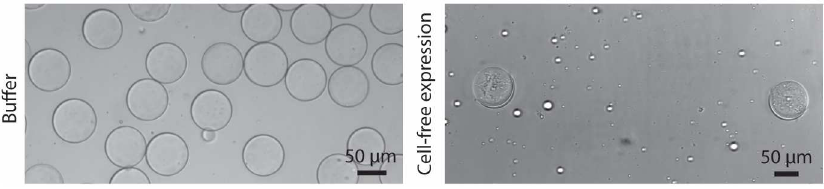
Fig 2. Aggregate was observed when CFE is encapsulated in the vesicle. (Top) Buffer solution (20 mM HEPES pH 7.5, 400 mM sucrose, 2% PVA, 8% PEG) was encapsulated as the inner phase using capillary droplet microfluidics with DOPC/cholesteroldissolvedin chloroform/hexaneas the middlephase (see materials and methods) (Bottom) HeLa CFE (18 μ l HeLa lysate, 4.5 μ l Mix 1 buffer, 5.4 μ l GADD34, 4.5 μ l T7 RNA polymerase, 3.6 μ l Mix 2 accessory factors and 3 μ l MscL DNA plasmid containing T7 promoter) with 2% PVA was encapsulated with DOPC/cholesterol dissolvedin chloroform/hexane as the middle phaseand incubatedat 32 degreesin a closed